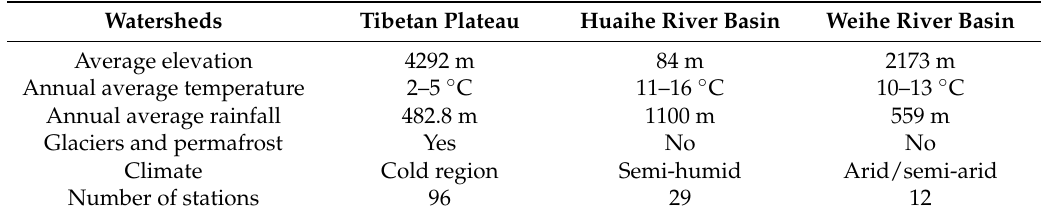
Table 1. Main features of the three studied